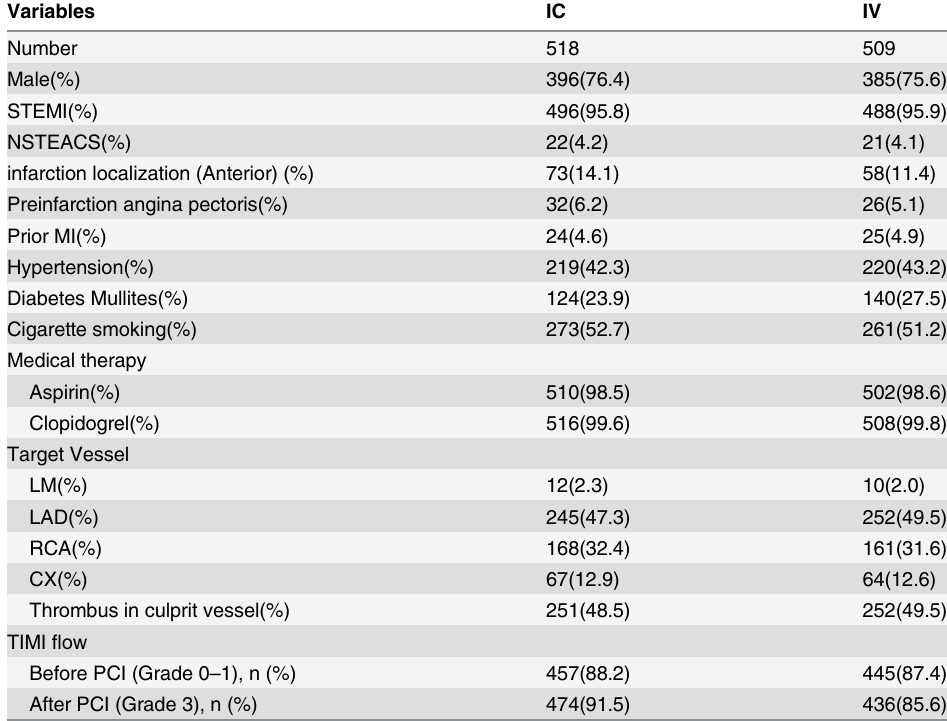
Table 3. Clinical and Procedural characteristics in the overall population. Variables IC